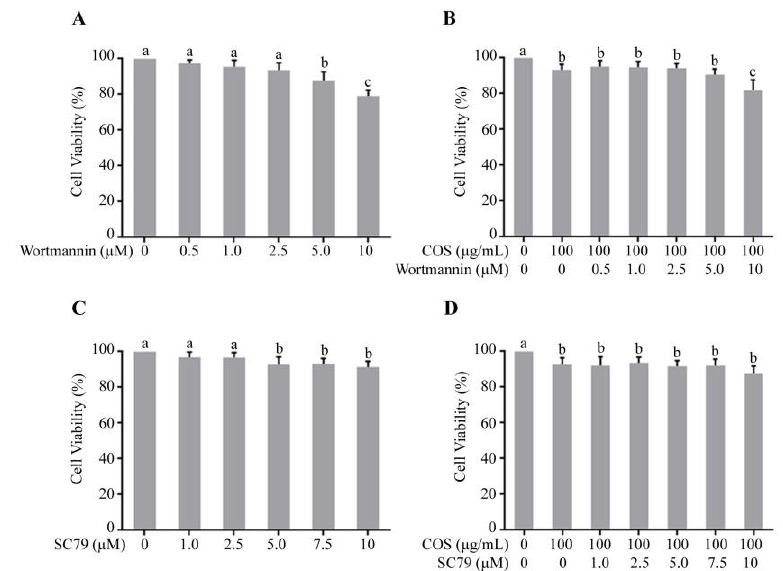
Figure 1. Effect of wortmannin and SC 79 in the presence or absence of COS on T84 cell viability. ( A ) Effect of wortmannin; ( B ) effect of wortmannin combined with COS; ( C ) effect of SC79; ( D ) effect of SC79 combined with COS. Data are expressed as mean ± SD of five independent experiments. Columns not sharing the same superscript letters differ significantly ( p <